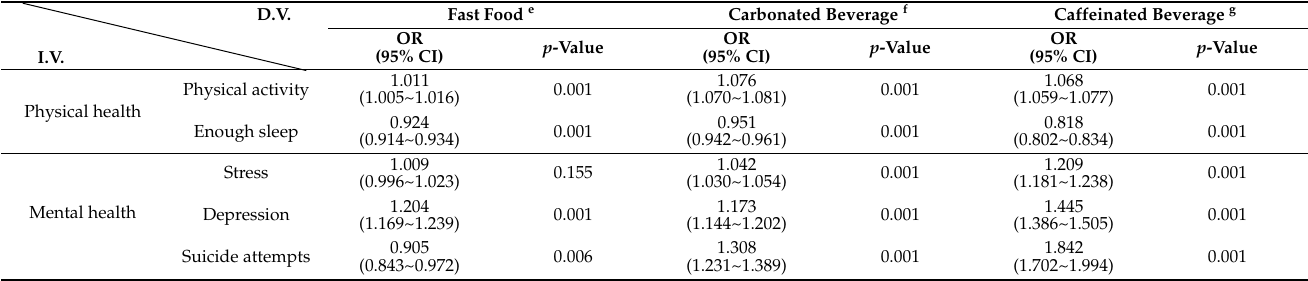
Table 9. Odds ratios for dietary intake according to physical and mental health